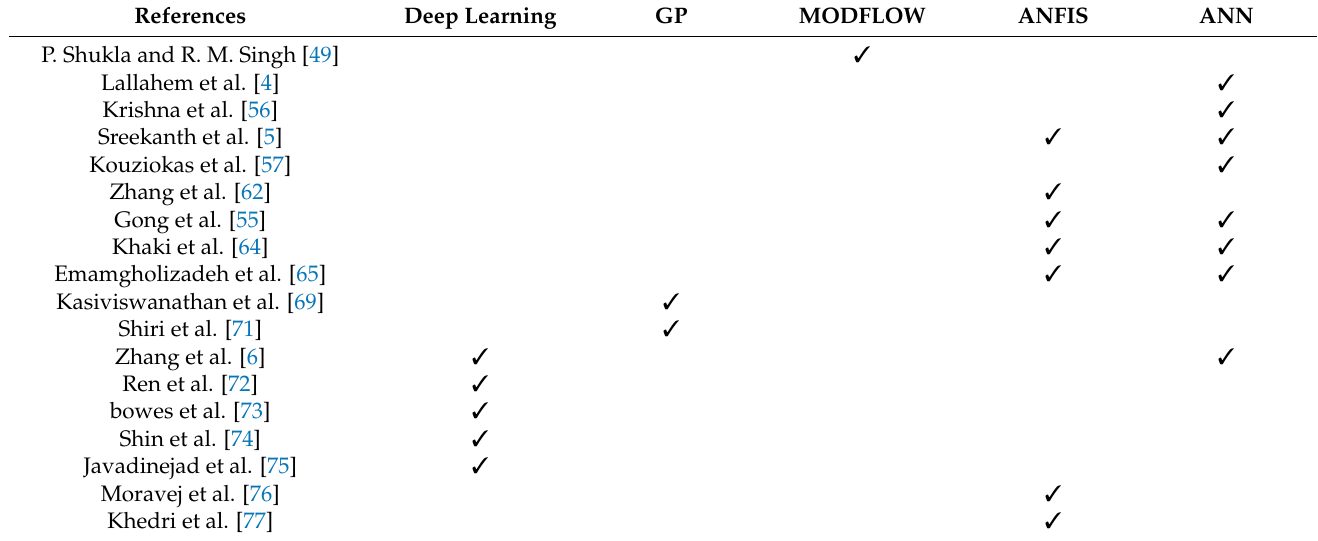
Table 3. Research categorized by different algorithms: deep learning, GP, MODFLOW, ANFIS,